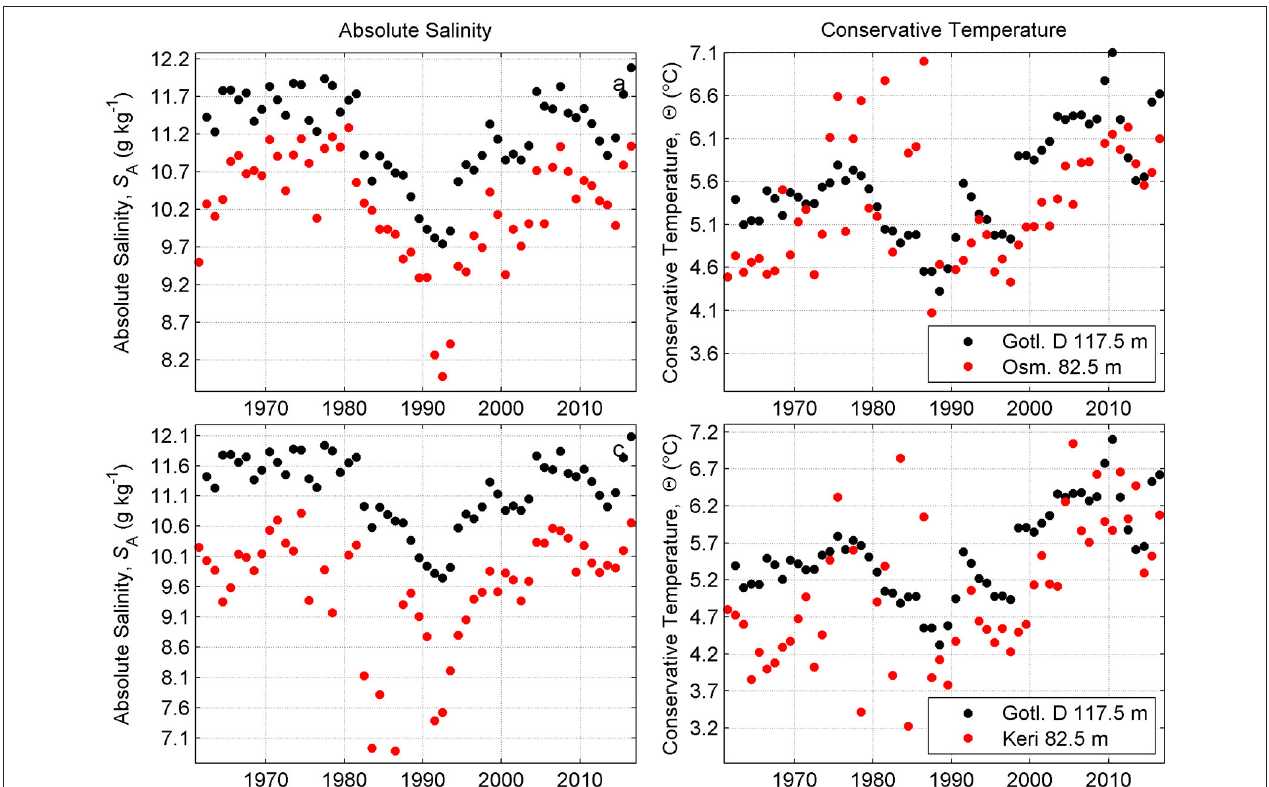
FIGURE 14 | Temporal course of yearly average salinity and temperature at 117.5 depth in the Gotland Deep, and yearly maximum salinity and temperature in the Osmussaar and Keri